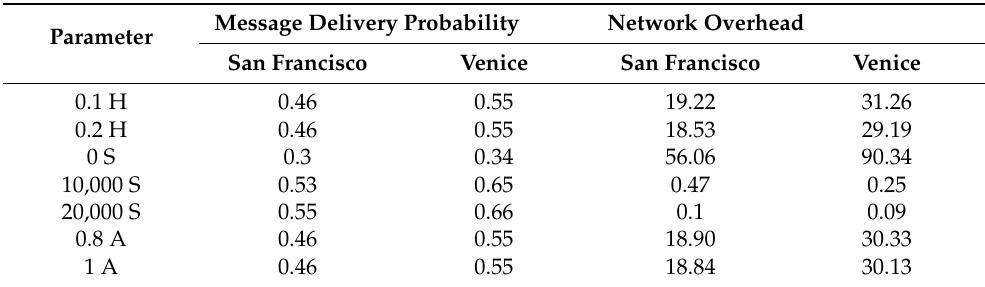
Table 5. Measures for messages’ delivery probability and network overhead ratio for the parameters of Blossom in San Francisco and